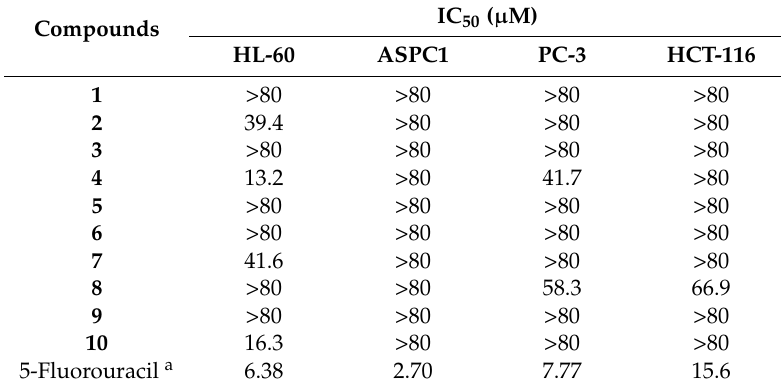
Table 3. Cytotoxicity of compounds 1 – 10 against four tumor cell